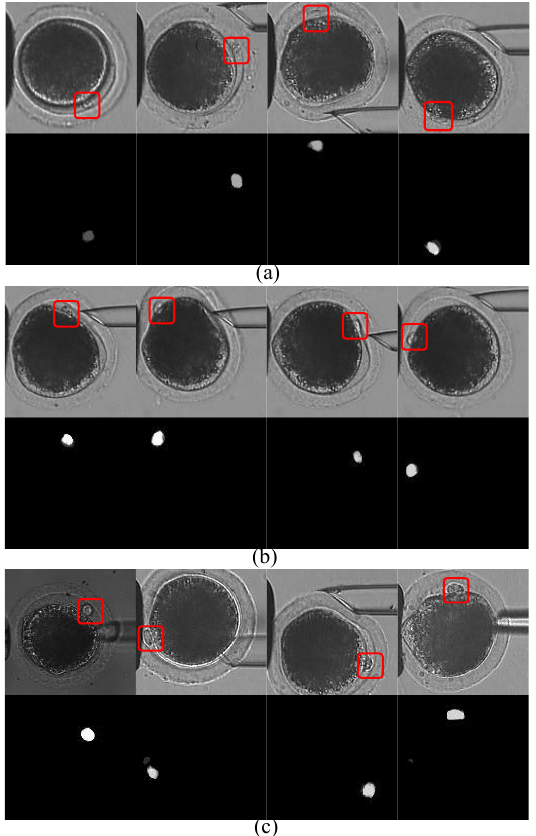
Figure 7. Polar-body detection results in ( a ) defocus situation; ( b ) deformation situation; and ( c ) different oocytes. For each detection result, top row shows the original oocyte image, bottom row shows corresponding segmented map. Polar bodies are marked by red rectangles for better